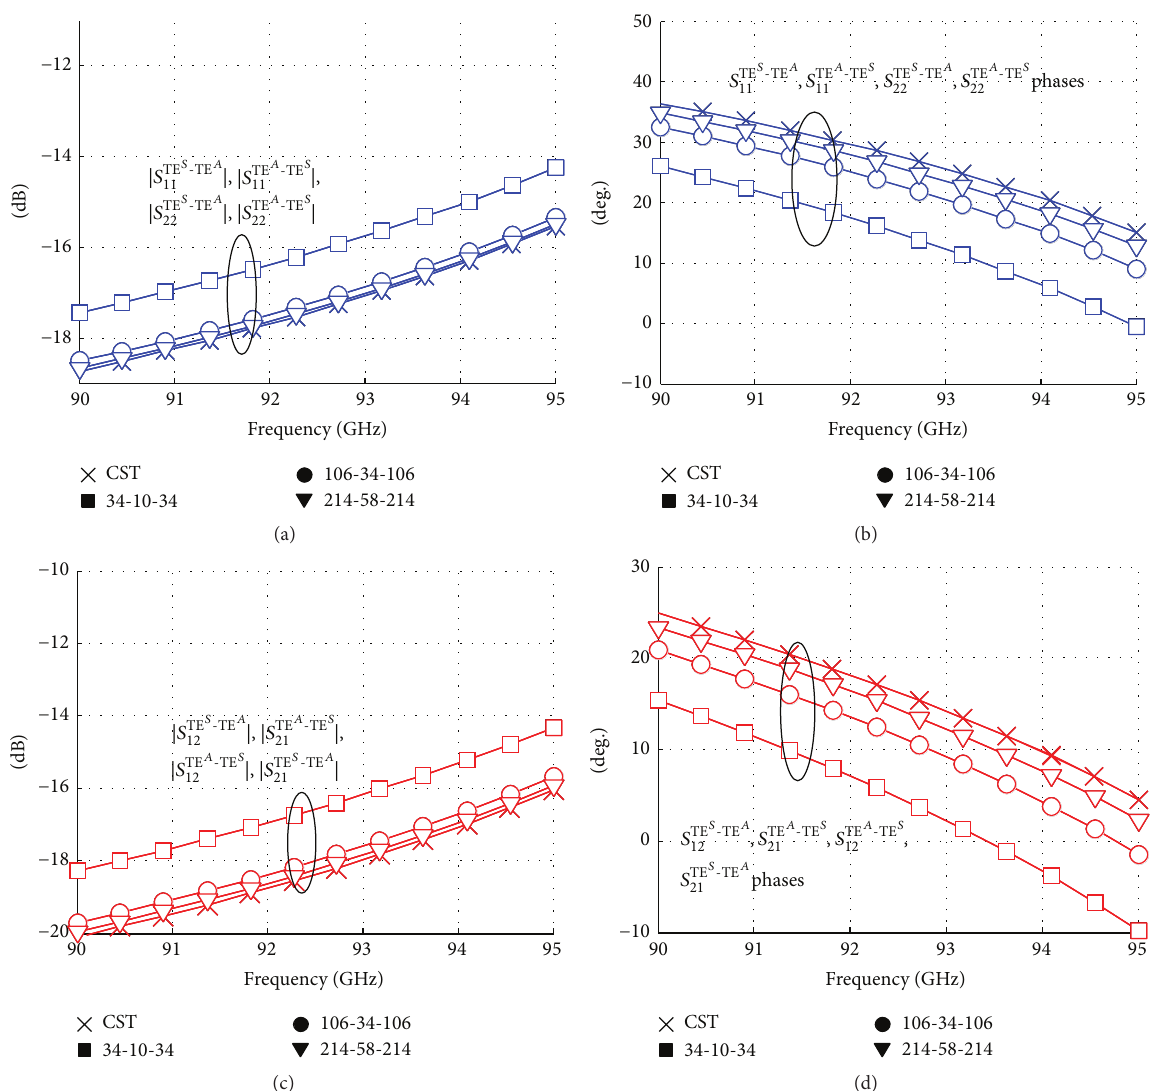
Figure 14: Case study c: mode TE 𝐴 10 in waveguide 1 to mode TE 𝑆 10 in waveguide 2 and mode TE 𝑆 10 in waveguide 1 to mode TE 𝐴 10 in waveguide 2 : (a) reflection magnitude, (b) reflection phase, (c) transmission magnitude, and (d) transmission